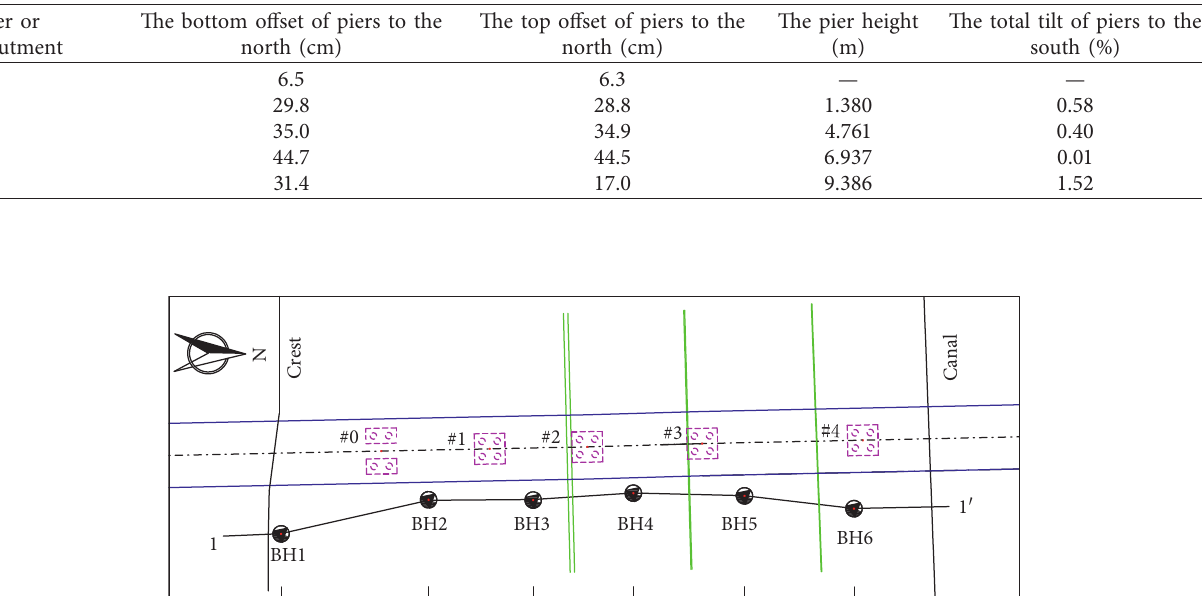
Table 1: Measurement of the horizontal deviation and inclination of the piers.